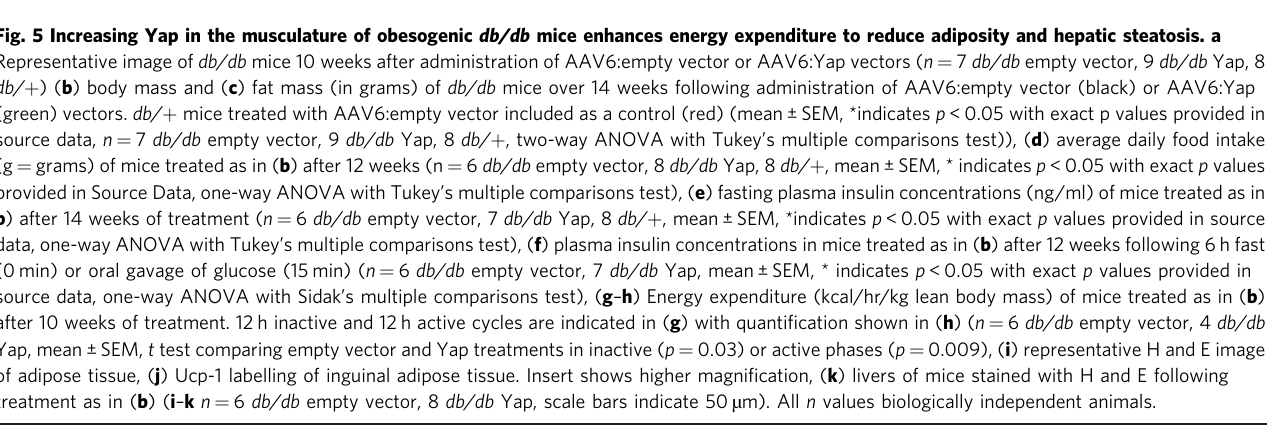
Fig. 5 Increasing Yap in the musculature of obesogenic db/db mice enhances energy expenditure to reduce adiposity and hepatic steatosis. a Representative image of db/db mice 10 weeks after administration of AAV6:empty vector or AAV6:Yap vectors ( n = 7 db/db empty vector, 9 db/db Yap, 8 db/ + ) ( b ) body mass and ( c ) fat mass (in grams) of db/db mice over 14 weeks following administration of AAV6:empty vector (black) or AAV6:Yap (green) vectors. db/ + mice treated with AAV6:empty vector included as a control (red) (mean ± SEM, *indicates p < 0.05 with exact p values provided